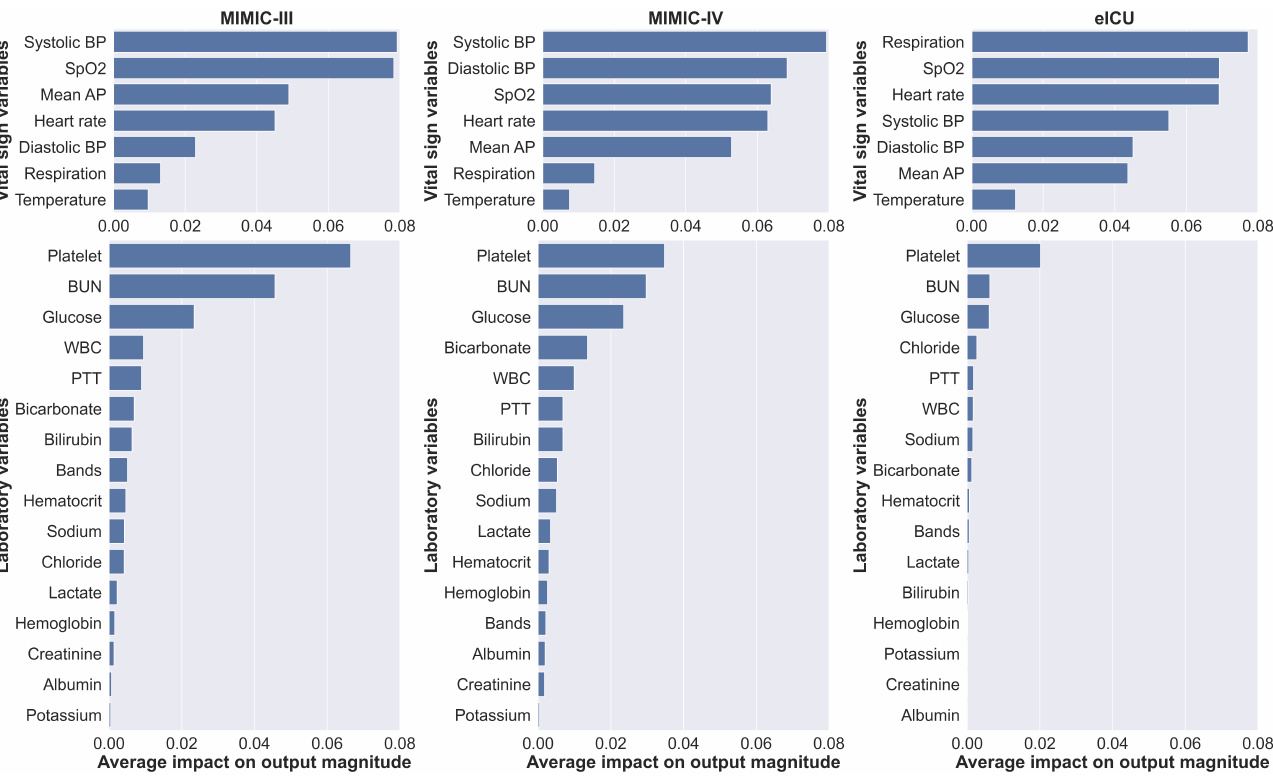
Figure 5. Feature importance indicating each feature’s average impact on the model prediction, ranked by the degree of importance for both vital sign and laboratory variables. Reasonable agreement was observed across